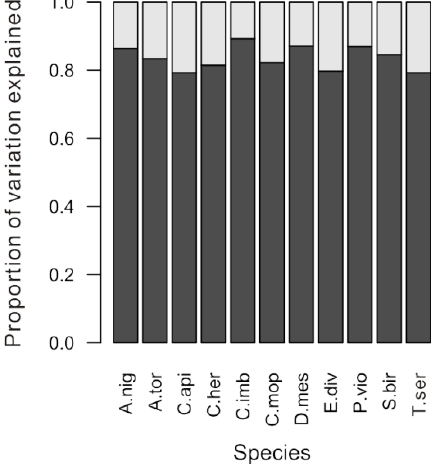
the bars represents the within-crown variation, and the light gray portion represents among-crown variation.